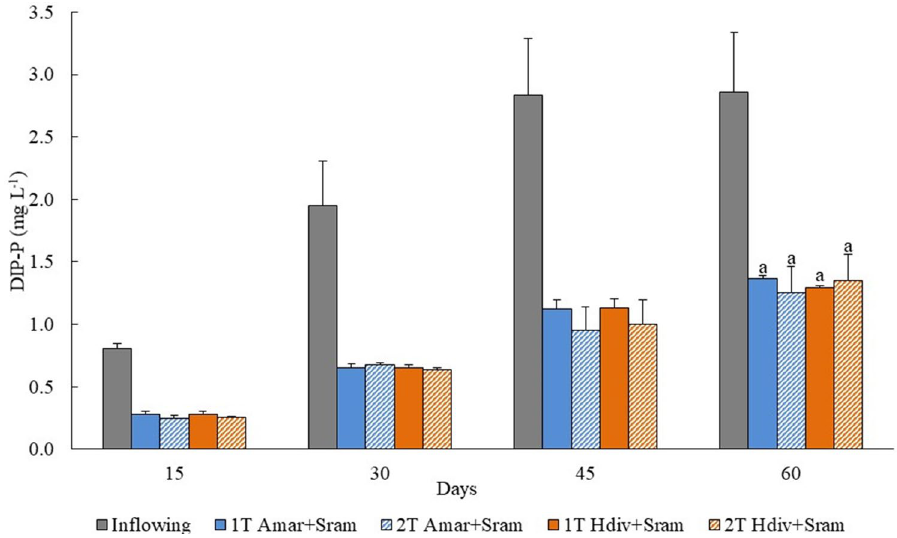
Figure 5. Dissolved inorganic phosphorus (DIP) quantified in the inflowing and outflowing effluent of IMTA designs tested using as extractive species polychaetes ( Arenicola marina —Amar—and Hediste diversicolor — Hdiv) and halophytes ( Salicornia ramosissima —Sram) cultured in the same tank (1 T) or in two separate tanks (2 T). Average values ± SD (n = 5). Statistical analysis performed only at 120 days when the biomass of extractive species was evaluated. No significant differences ( p < 0.05) between IMTA designs were observed.